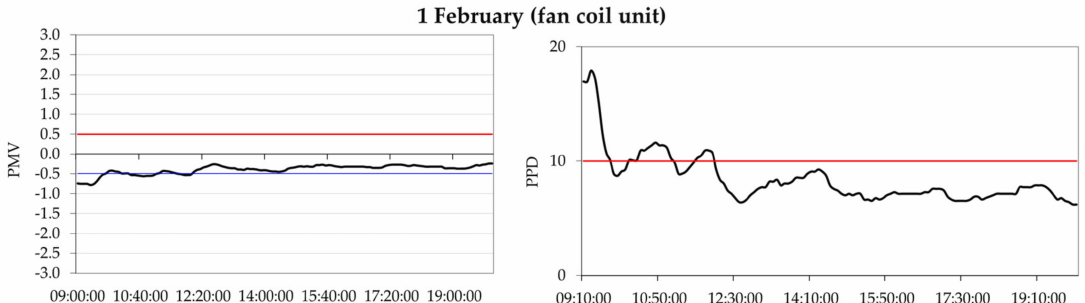
Figure 4. PMV and PPD calculation: fan coil